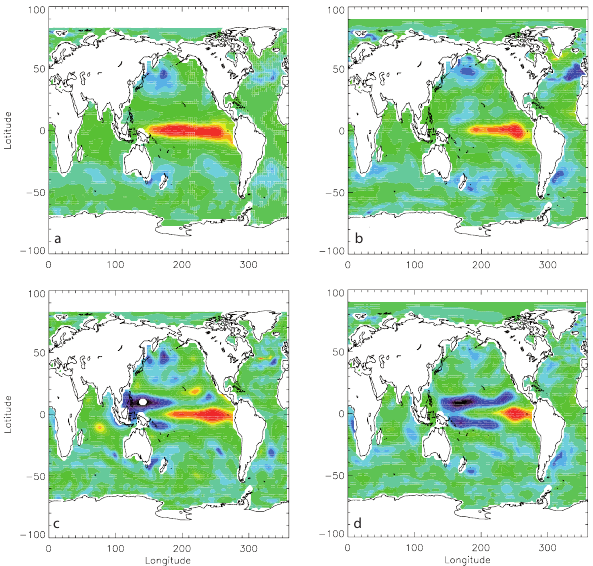
Fig. 1. Regression of the Niño3.4 Index on SST anomalies (top) and 0–200m temperature (bottom) averaged over the Niño3.4 region for the unperturbed simulation (left; a and c ), and the breeding experi- ment (right; b and d ). Colors represent the same value in all figures, as normalized values are